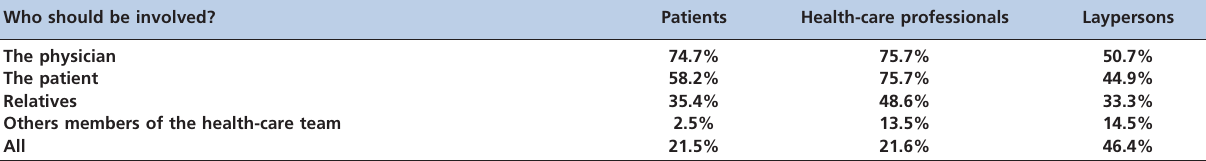
Table 1 - Responses to the question about who should be involved in treatment decisions for a fictitious cancer patient (the responses did not add up to 100%).